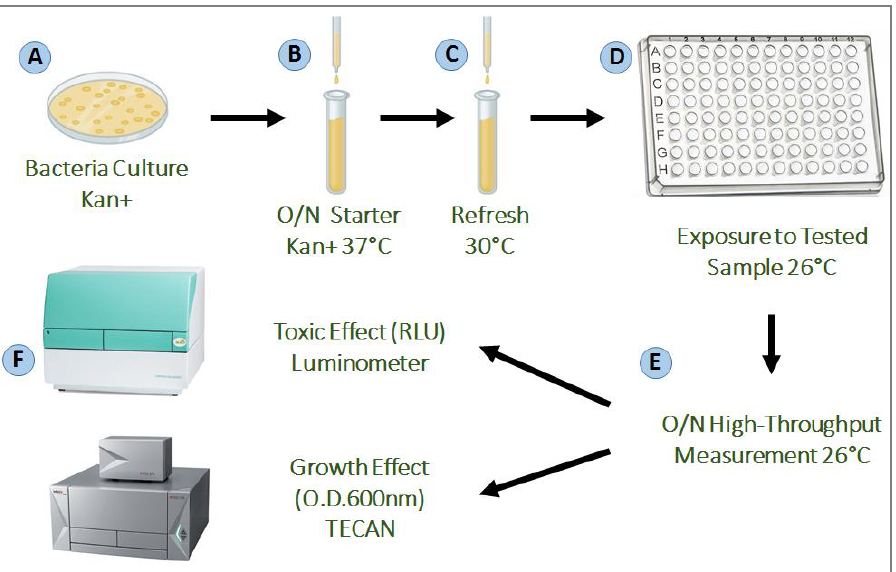
Figure 3. Experimental process. ( A ) each bacteria strain tested was striked on an agar plate containing Kanamycin, and incubated overnight at 37 °C; ( B ) a starter was grown from a single colony from the striked plate, and incubated overnight at 37 °C in a shaking incubator; ( C ) the starter was refreshed by adding 200 μL of the overnight culture into 10 mL of fresh LB, and then grown for 3–4 h at 30 °C in a non-shaking incubator; ( D ) the bacteria strains were then exposed to the different samples of different concentrations in a high-throughput measurement using a 96-well plate; ( E , F ) the toxicity (Relative Light Unit (RLU)) and growth (O.D. 600 nm) signals were measured continuously during the 16 h incubation at 26 °C, in the Luminometer and TECAN reader, respectively.